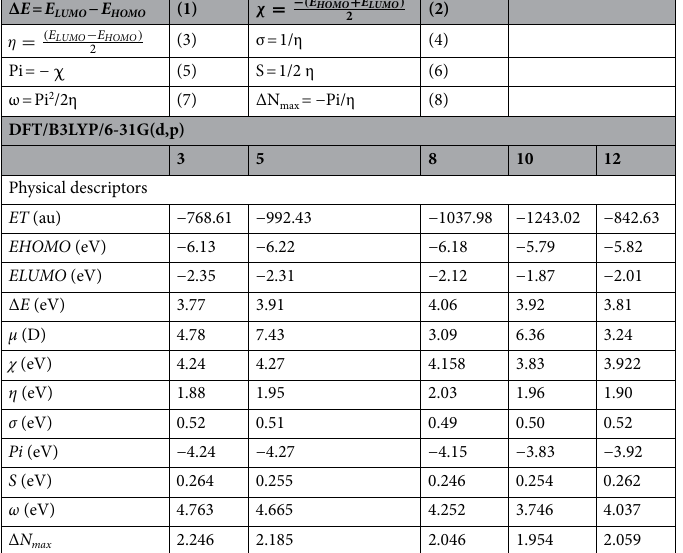
Table 3. Ground state energies of compounds utilizing DFT/B3LYP/6-31G(d,p) and their physical parameters.